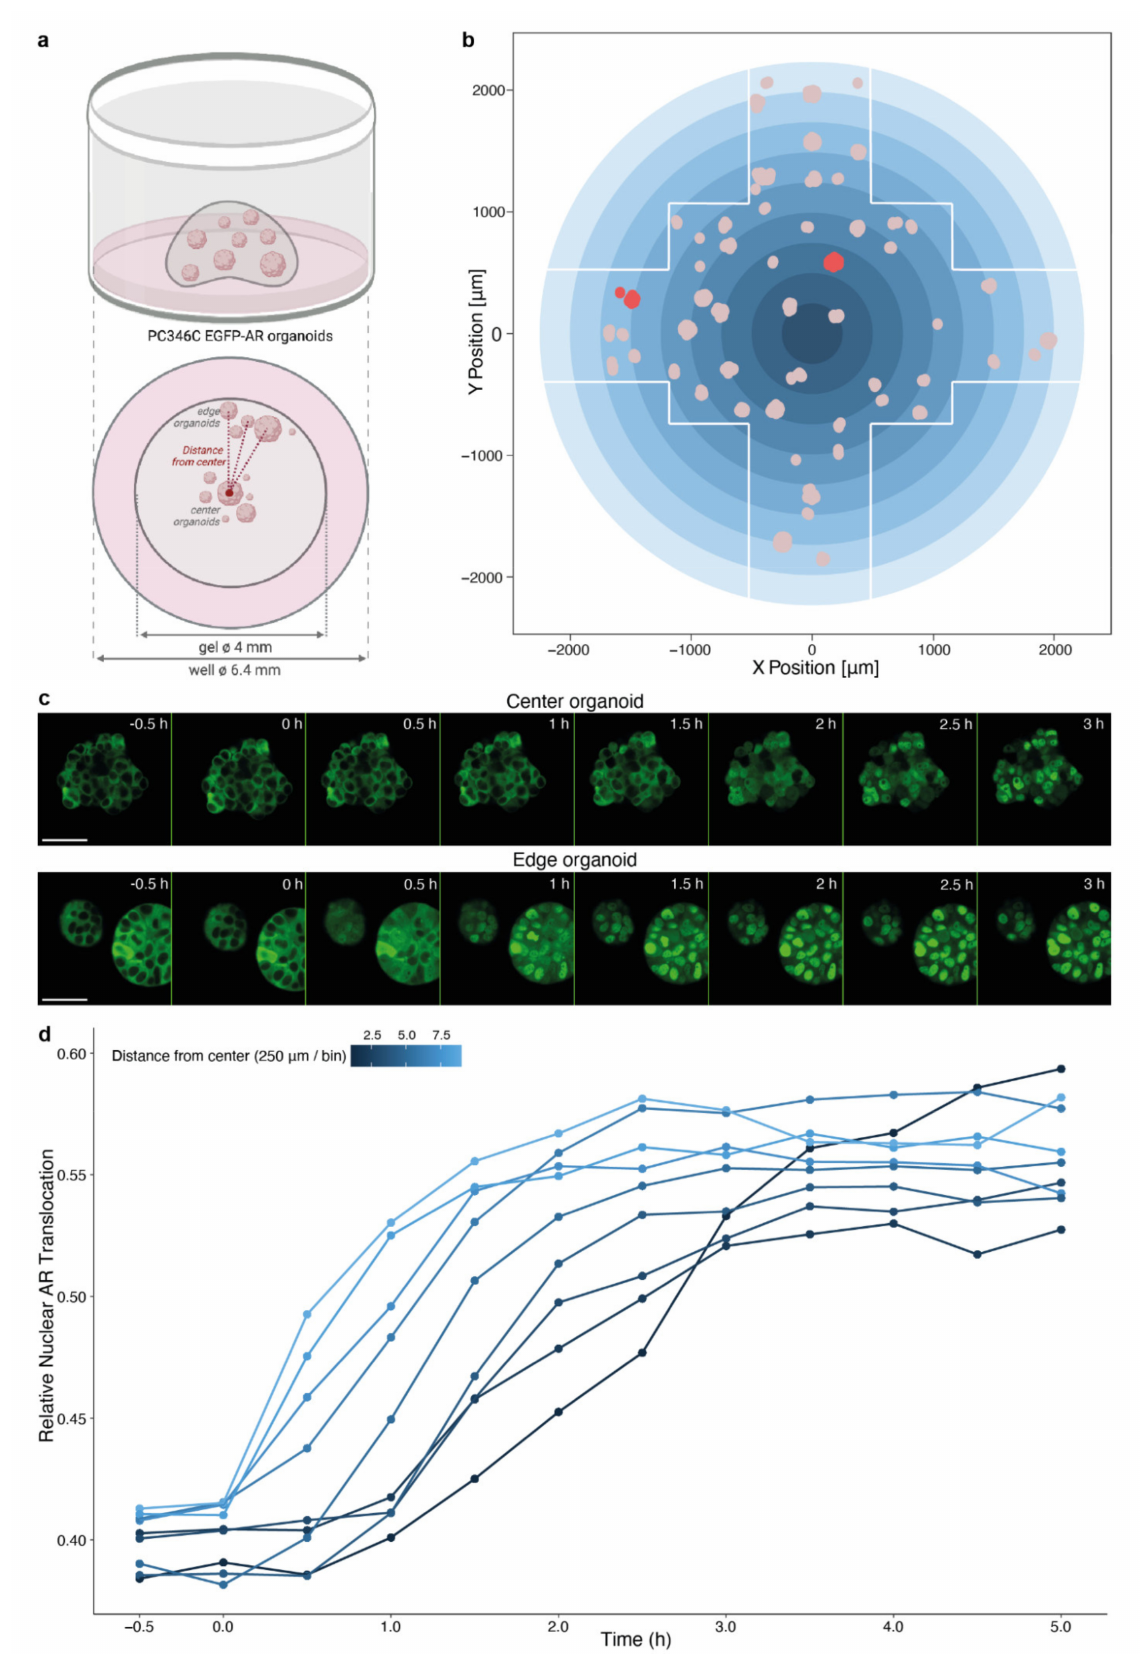
Figure 4. Impact of spatial organoid distribution within a Matrigel dome on androgen-induced AR translocation. ( a ) Schematic representation of experimental design. ( b ) Illustration of organoid distribution within a single imaged well,